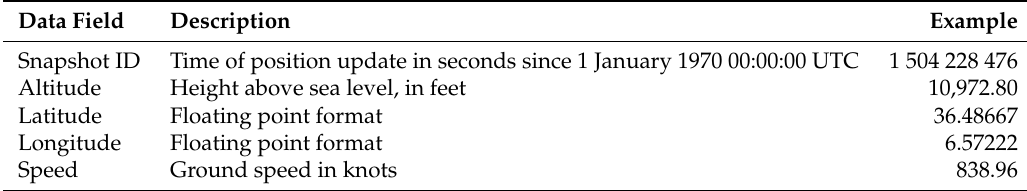
Table 2. Metadata of the dataset segment containing the trajectory